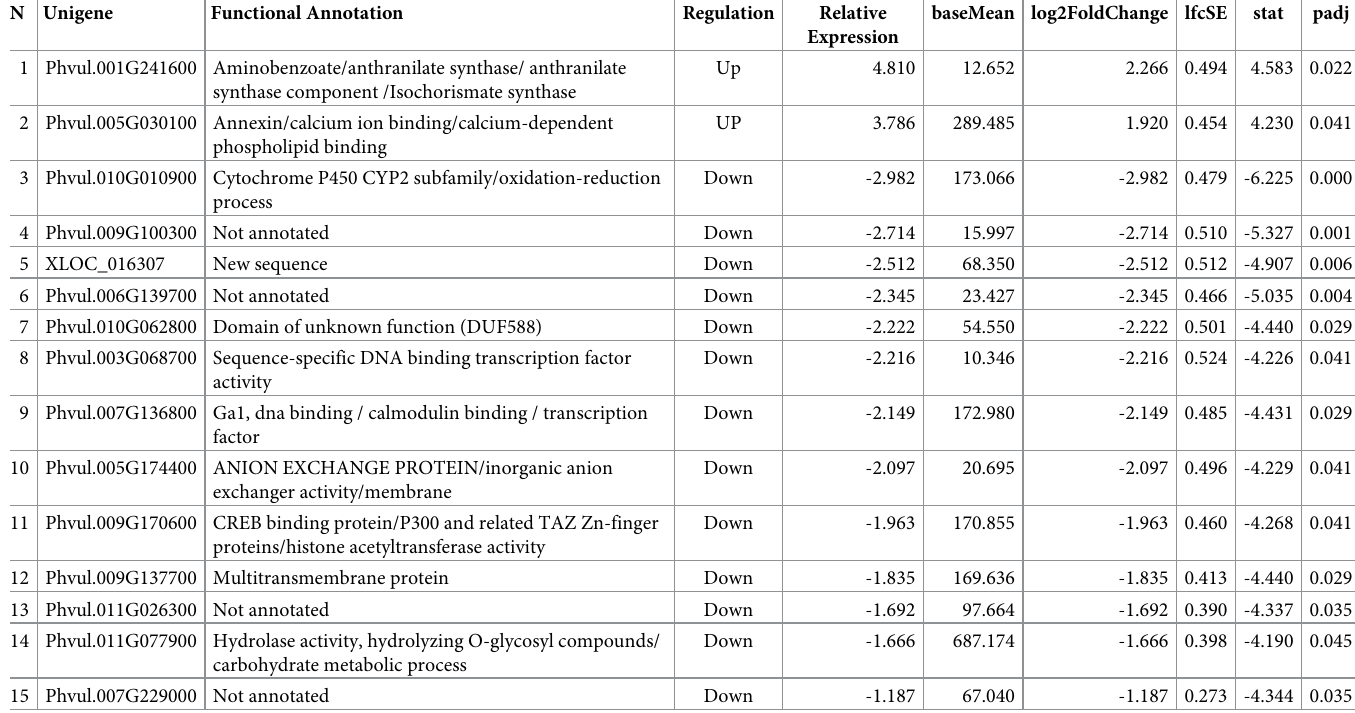
Table 8. Unigenes induced from the DOR 364 genotype (increasing order of log2FoldChange). From left to right: gene id (Phytozome); annotation of the gene based on blastx search using the database of P. vulgaris (Phytozome) with a cutoff of 1e-10; regulation; relative expression comparing restrictive P vs. control P level; baseMean; log2FoldChange; lfcSE (standard error);